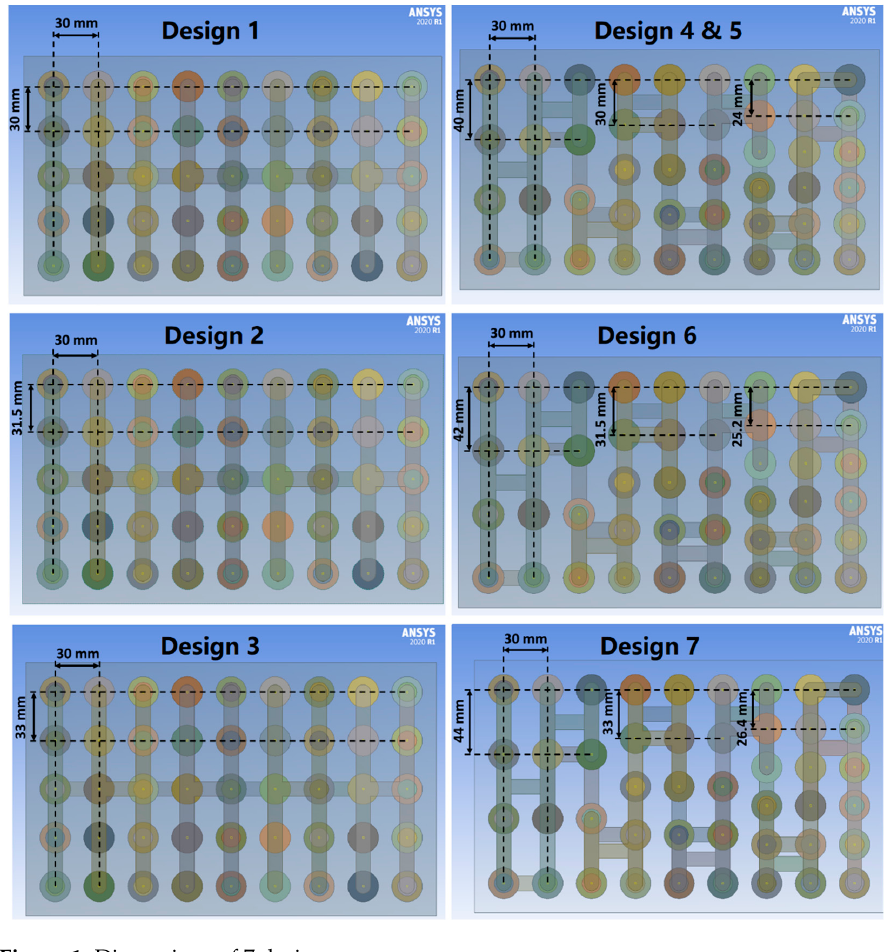
Figure 1. Dimensions of 7 designs.